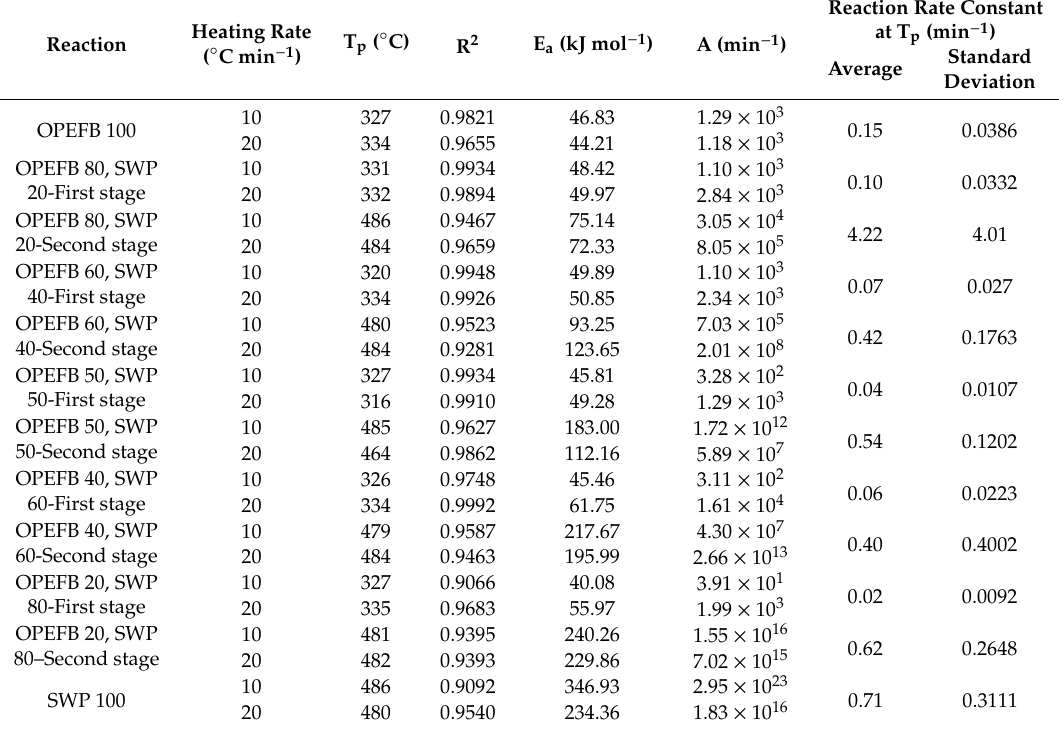
Table 3. Kinetics parameters of samples at di ff erent heating